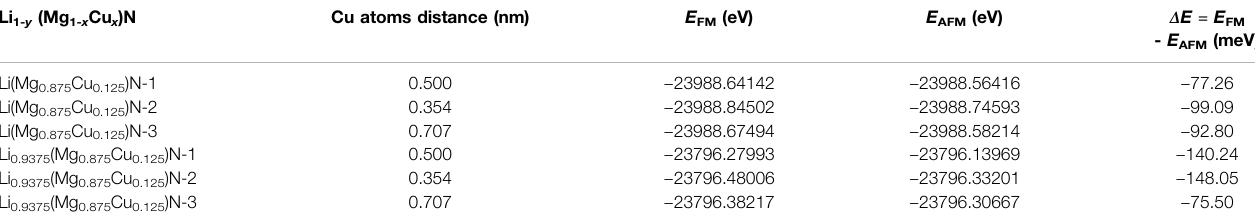
TABLE 2 | The ferromagnetic and anti-ferromagnetic coupling energy of Li 1- y (Mg 0.875 Cu 0.125 )N with different Cu doped position. Li 1- y (Mg 1- x Cu x )N